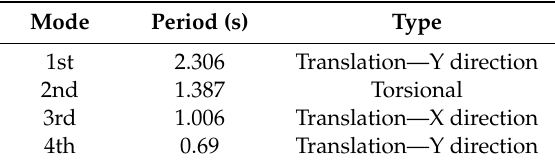
Table 1. Fundamental periods of the hospital